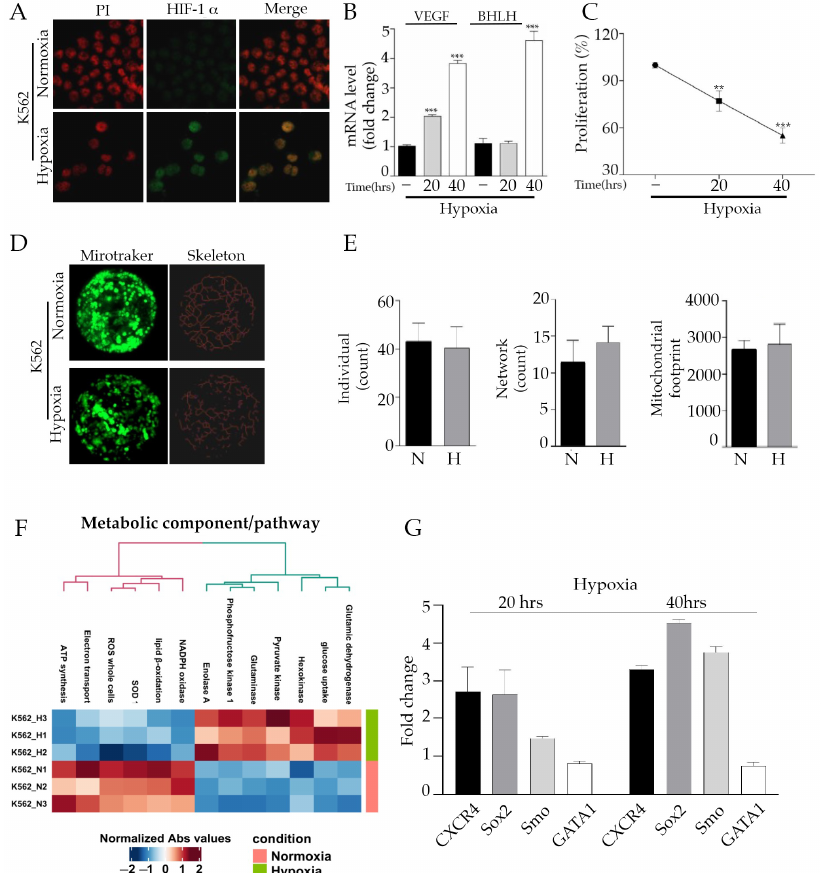
Figure 1. Hypoxia activates a quiescent state in Philadelphia-positive (Ph+) cell line: ( A ) Immunofluorescence of K562 cells incubated under hypoxic conditions for 20 and 40 h. The green nuclear staining corresponding to HIF-1 α , a known marker of hypoxia, was registered after 40 h of low oxygen. Red propidium was used for nuclei staining. ( B ) Vascular endothelial growth factor ( VEGF ) and HIF-1 α Subunit ( BHLH ) gene expression was assayed by quantitative reverse transcription PCR (qRT-PCR) in K562 cells under normoxic and hypoxic conditions. The significant rise observed was indicative of low oxygen tension. ( C ) K562 cells under hypoxic conditions for 20 and 40 h were subjected to MTT assay to evaluate the proliferation index. The percentage of proliferation is expressed after normalizing with normoxia cells (100%). ( D ) The original green image obtained with confocal microscope is a Z-stack reconstruction image created (63× magnification) after mitotraker staining. It has been processed by MiNA toolset to draw an accurate skeleton of the mitochondria within the cell. ( E ) The number of individuals (unbranched structures), the number of networks (mitochondrial branched structures) and the mitochondrial footprint (the area occupied by mito- chondrial structures) are unchanged between hypoxia vs. normoxia conditions. ( F ) Metabolic analysis profile of normoxic and hypoxic conditions. The results of a hierarchical clustering calculation applied on data are displayed in the heat map as a dendrogram. Heatmap represents processes with a significantly reduced activity in blue while processes with a significantly increased activity are in red. K562 H1, 2 and 3 corresponded to hypoxic condition triplicates. K562 N1, 2 and 3 represented the normoxic condition triplicates. ( G ) mRNA analysis of well-known stem cell markers ( CXCR4 , SOX2 , SMO and GATA-1 ) in K562 cells under normoxia or hypoxia. Gene expression was represented as fold changes compared to normoxic conditions. ** p ≤ 0.01 and *** p ≤